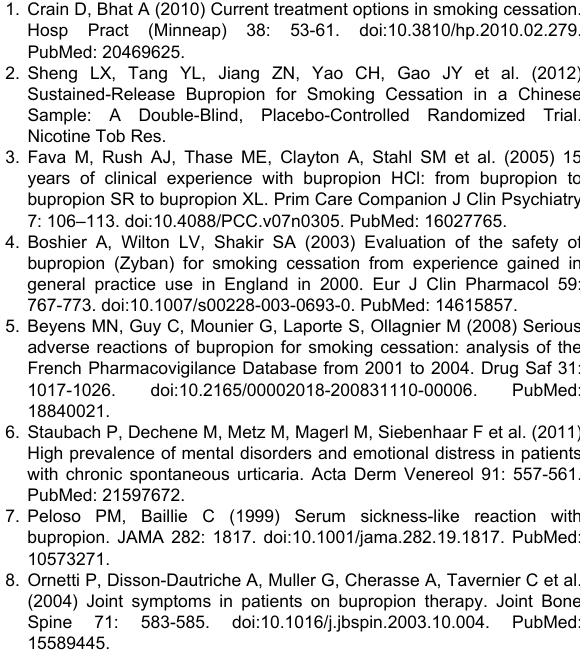
Table S1. Scaled Schoenfeld residuals test of proportional hazards.